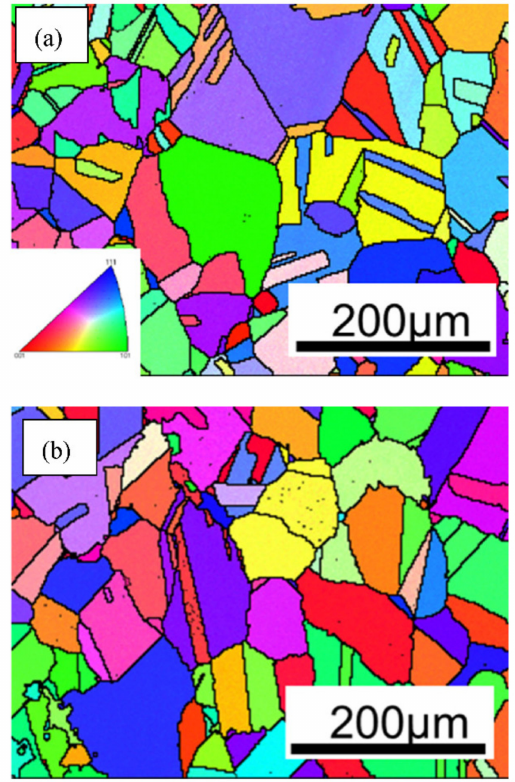
Figure 3. IPF maps of Fe–Mn–Cr–CN TWIP steels: ( a ) 12CrN; and ( b ) 18CrN.